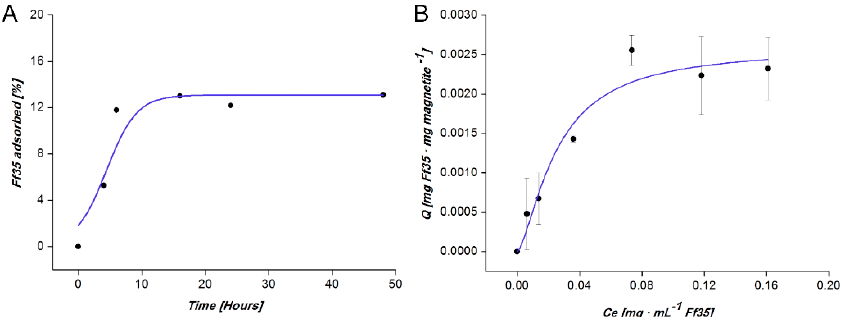
Figure 3. Adsorption kinetics ( A ) and adsorption isotherm ( B ) of Ff35 on BMNPs. The line represents the nonlineal weighted least-squares (NWLS) fitting of the experimental data according to LF model. In the case of adsorption kinetics, the vertical error bars are smaller than the symbol.